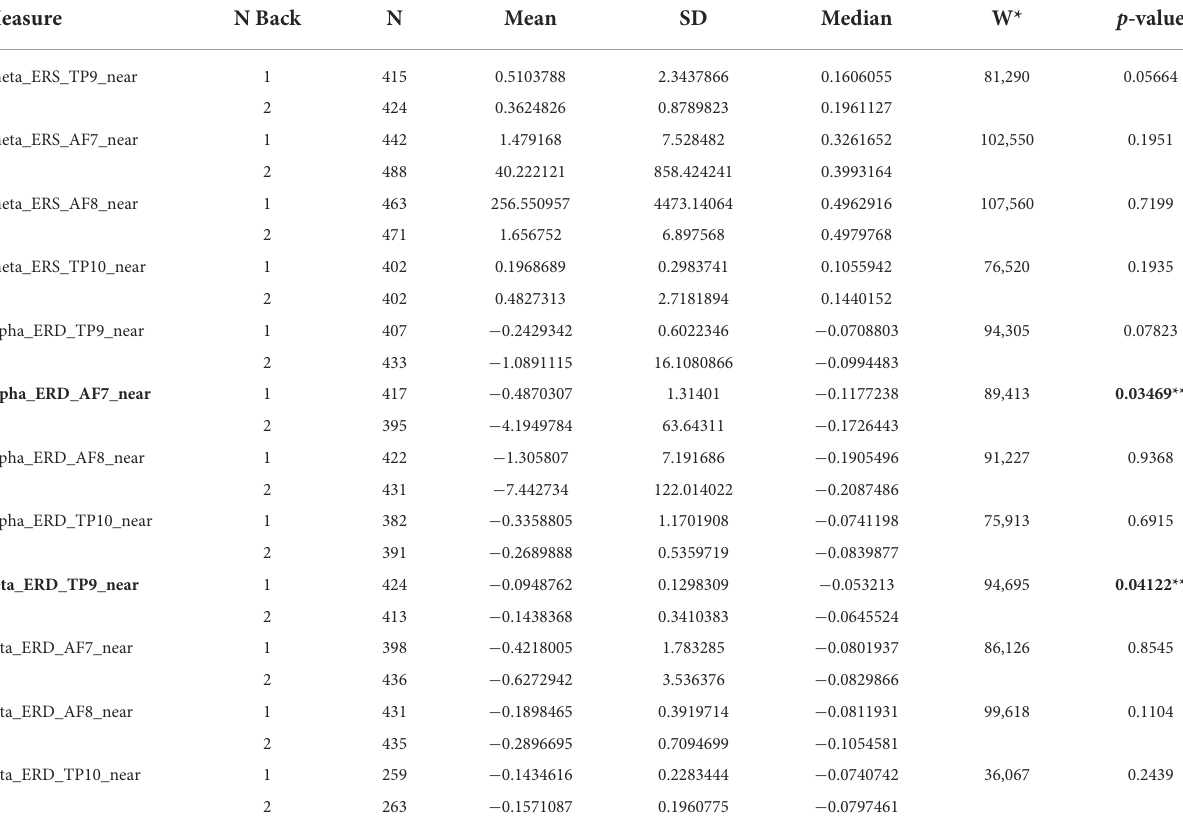
TABLE 3 The descriptive statistics and Mann–Whitney–Wilcoxon test results for averages of ERD of Alpha, Beta, and ERS of Theta for TP9, TP10, AF7, and AF8 with baseline near between 1 and 2 back.